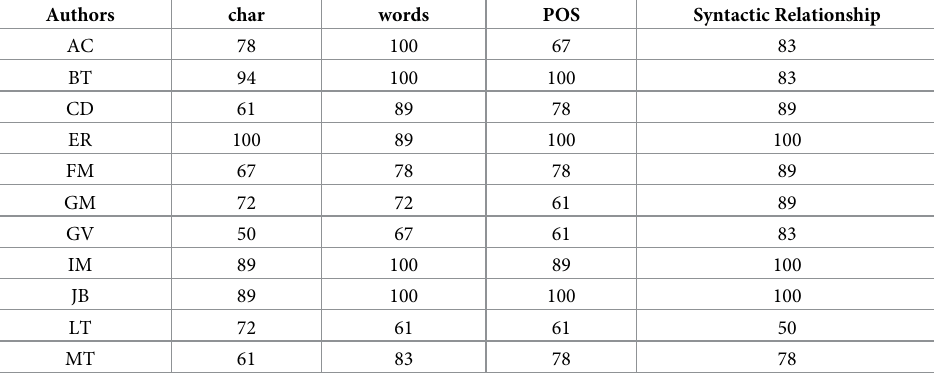
Table 11. Accuracy (%) using 3-grams in complete novels using ALL features.